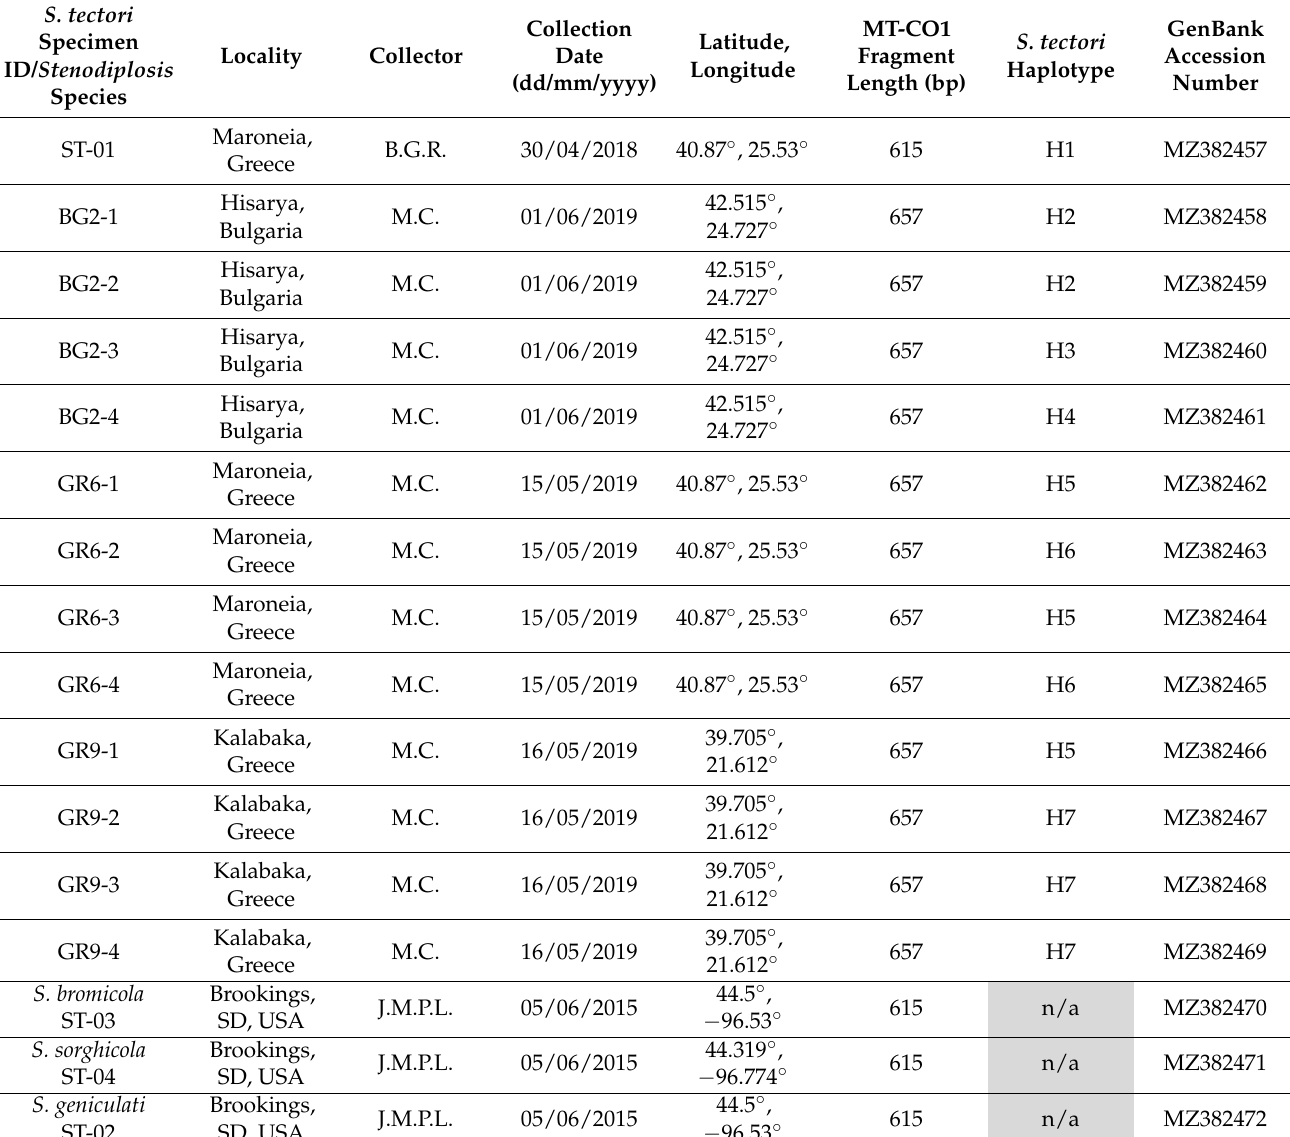
Table 1. List of the sequenced specimens used in this study with respective collection records and associated GenBank accession numbers. Grey background with n/a = not